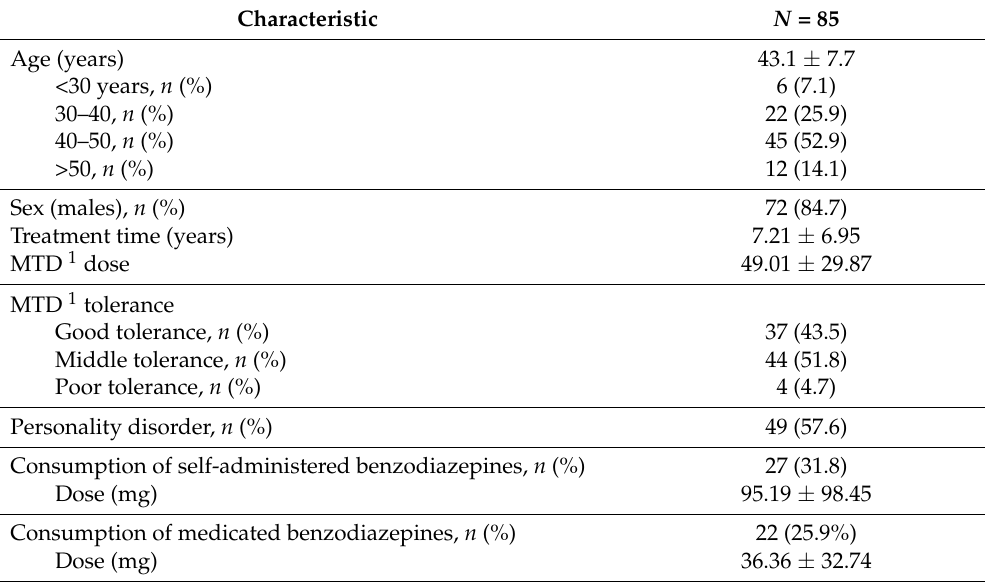
Table 1. Clinical and sociodemographic